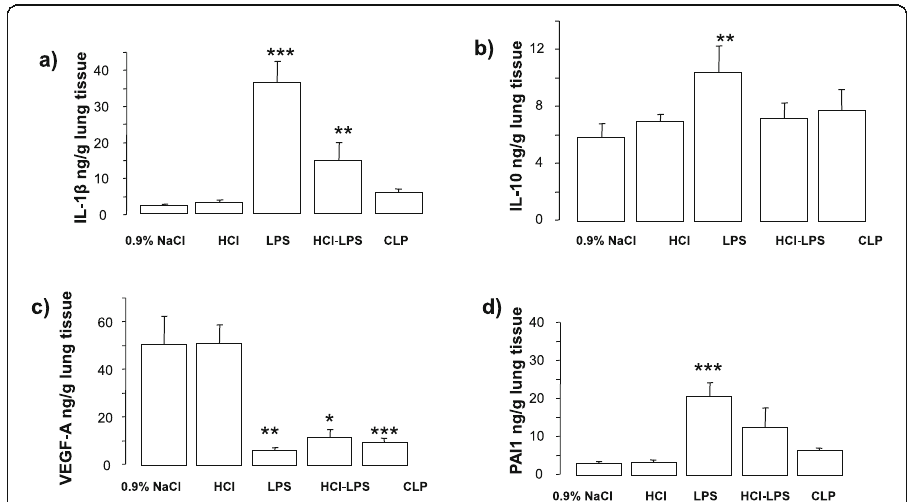
Fig. 5 Cytokine IL-1 β a, b IL-10, c VEGFA, and d PAI-1 concentrations in lung homogenate of animals 24h after induction of the injury. Data are presented as mean±SEM. IL1 β , LPS *** p < 0.0001 vs 0.9% NaCl, HCl, or CLP; HCL-LPS: ** p < 0.01 vs 0.9% NaCl, HCl, or CLP; IL-10, LPS: ** p < 0.01 vs 0.9% NaCl; VEGFA, LPS, HCL- LPS, CLP *** p < 0.0001 vs 0.9% NaCl, HCl; PAI-1, LPS: *** p < 0.0001 vs 0.9% NaCl, HCl, or CLP; HCL + LPS: * p < 0.05 vs 0.9% NaCl, HCl, or